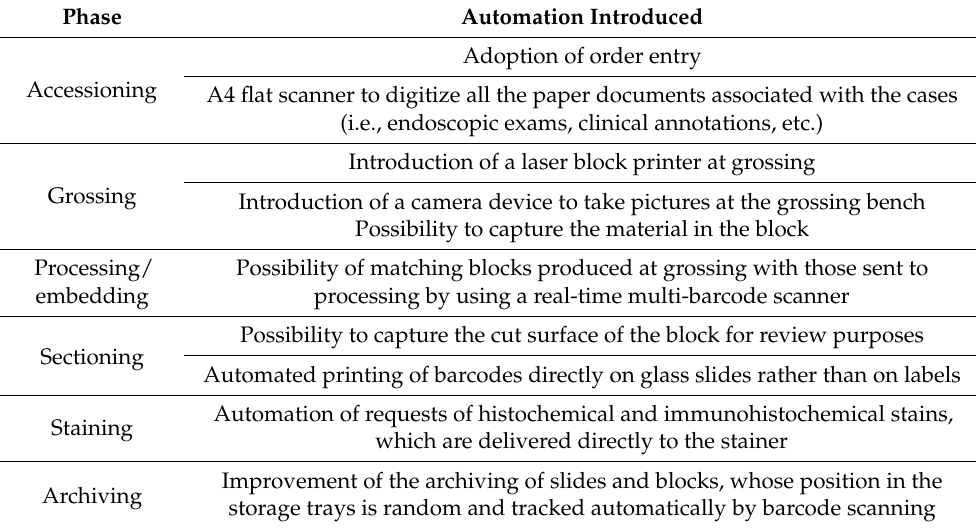
Table 1. Automation introduced at every step of the workflow.